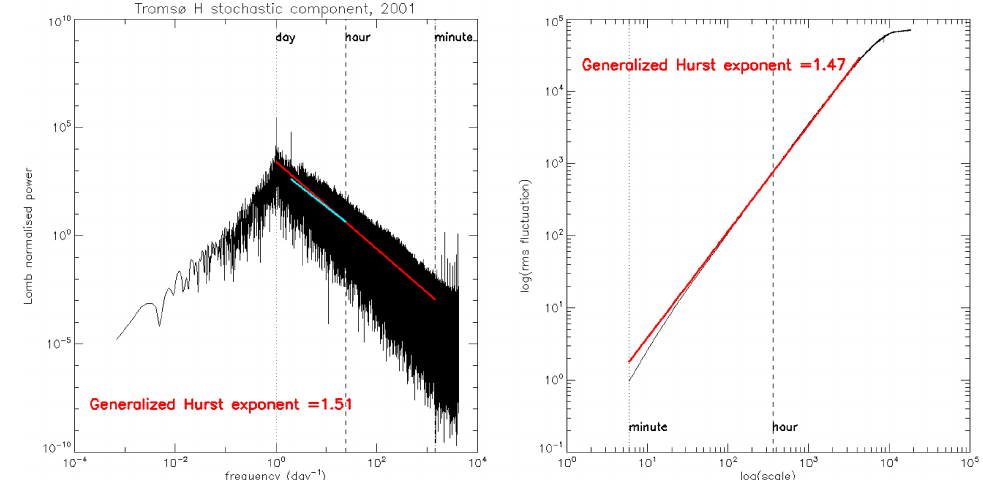
Figure 3. Spectral (left) and detrended fluctuation (right) analyses for data shown in previous figures. Familiar timescales are indicated by vertical dotted/dashed lines. Fitted scaling exponents are shown by coloured lines together with corresponding